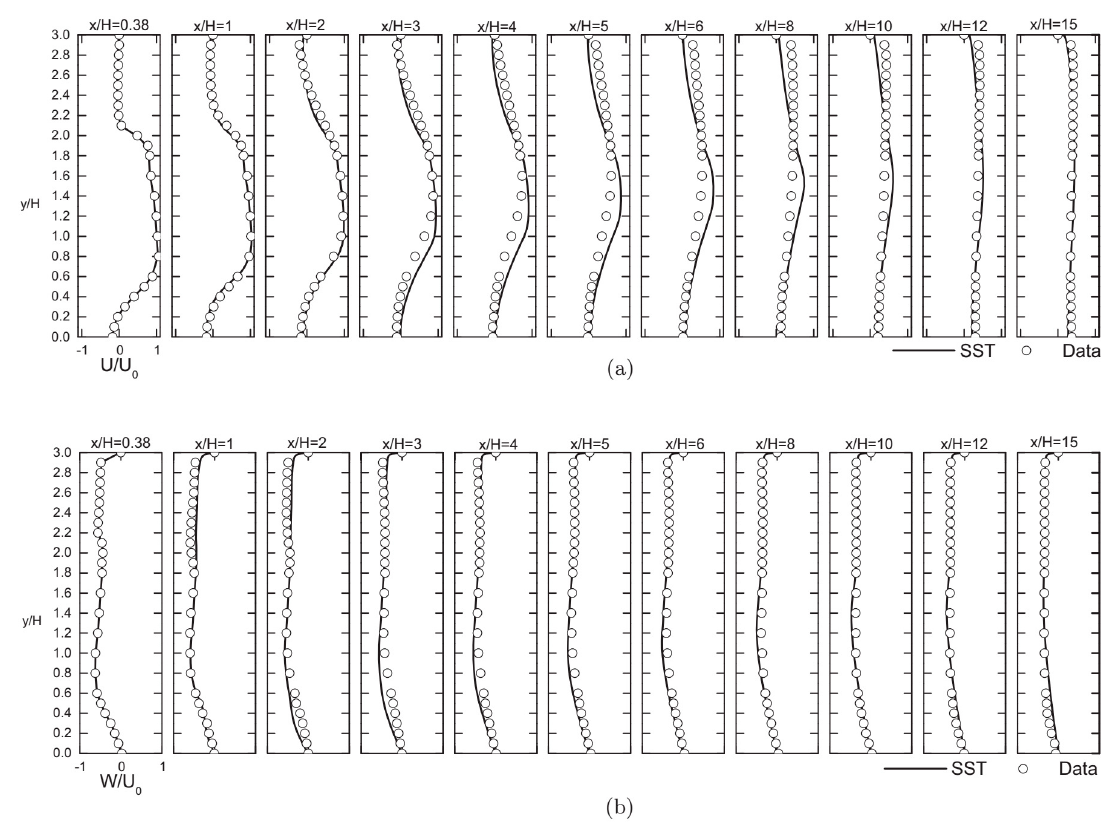
Figure 9. Normalized axial velocity ( a ) and tangential velocity ( b ) at different axial position .